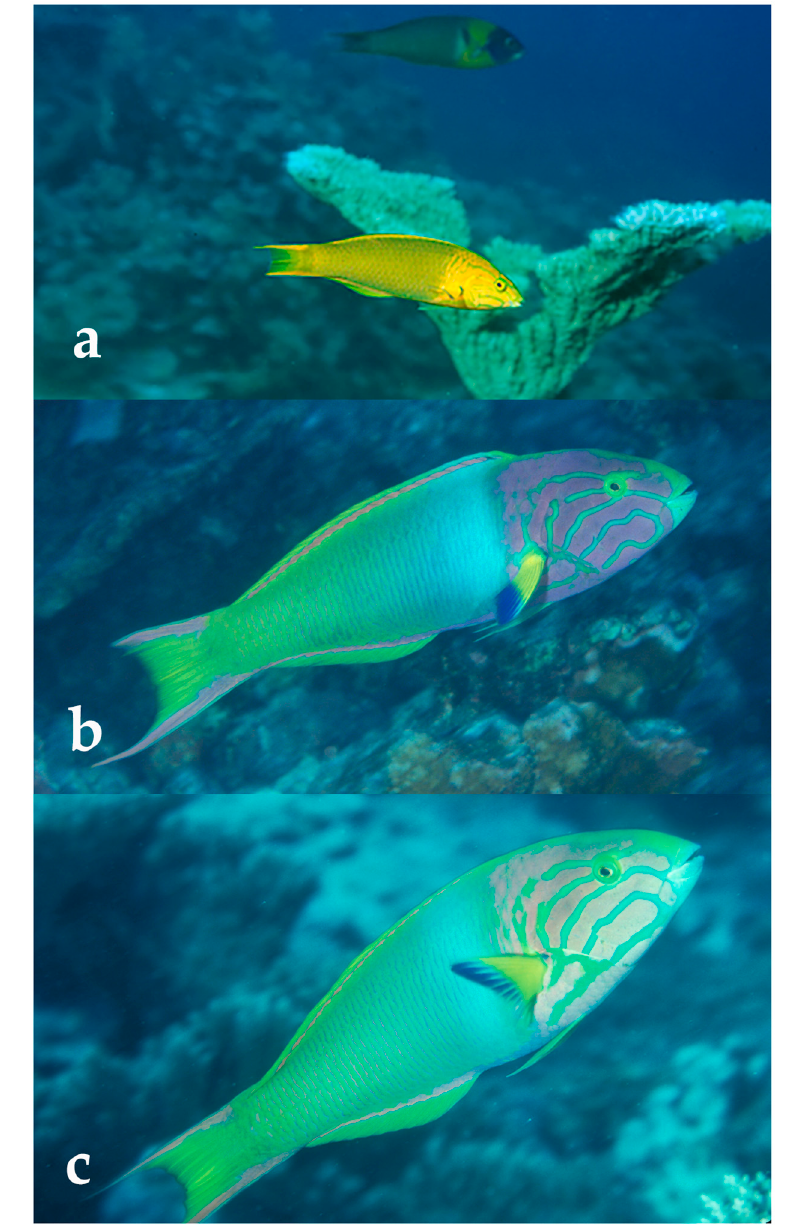
Figure 5. Thalassoma lutescens at Johnston Atoll: ( a ) initial phase with a T. duperrey in the background and ( b , c ) variation in terminal male coloration.